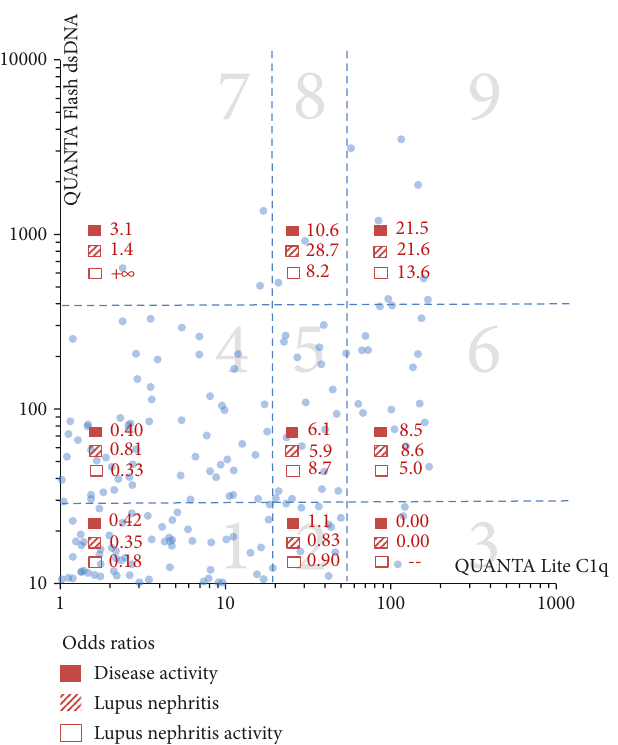
Figure 4: Anti-dsDNA and anti-C1q combined odds ratios for the assessment of disease activity, lupus nephritis, and lupus nephritis activity. The dotted lines sectioning the graphs into 9 groups represent di ff erent cut-o ff selections including the manufacturer ’ s cut-o ff points at 27IU/mL for anti-dsDNA and 20 units for anti-C1q antibodies and optimized cut-o ff points at 390 IU/mL for dsDNA and 54 units for C1q. The di ff erent sections of the graph are indicated by numbers (1 – 9). The x and y -axes are shown in logarithmic scale. The symbol ( – ) stands for odds ratios that cannot be calculated due to patients not having values within the range of the respective quadrant.